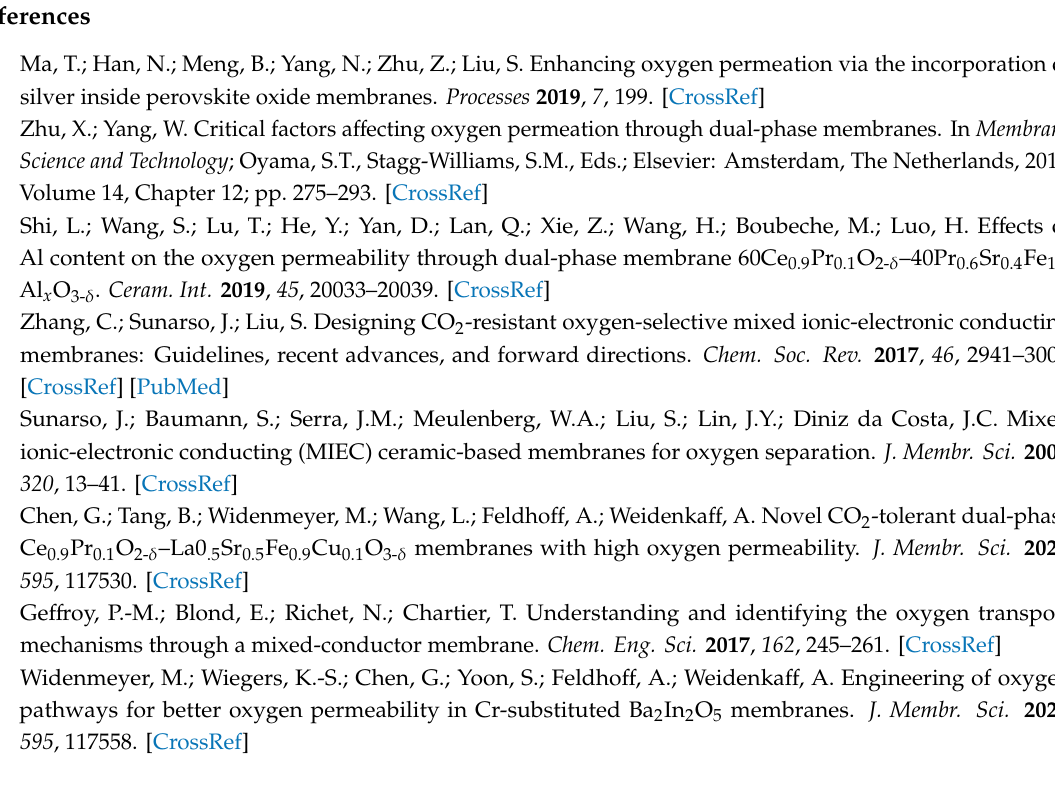
Figure S1: Schematic diagram of the experimental setup for oxygen permeation measurements; Figure S2: Long-term oxygen permeation flux through a Ce 0.9 Pr 0.1 O 2 − δ –Nd 0.5 Sr 0.5 Fe 0.9 Cu 0.1 O 3 − δ membrane at 1223 K under air / He or air / CO 2 gradient. Test conditions: 150 mL min − 1 synthetic air as the feed gas; 29 mL min − 1 CO 2 as the sweep gas; 1 mL min − 1 Ne as an internal standard gas; membrane thickness: 0.6 mm; Figure S3: XRD pattern of the sweep side (pure CO 2 ) of the Ce 0.9 Pr 0.1 O 2 − δ –Nd 0.5 Sr 0.5 Fe 0.9 Cu 0.1 O 3 − δ dual-phase membrane after 70 h O 2 permeation measurements as shown in Figure S2 under air / CO 2 gradient (Bruker D8 Advance instrument with Cu- K α 1,2 radiation); Table S1: Summary of the starting material costs generally used in dual-phase membrane